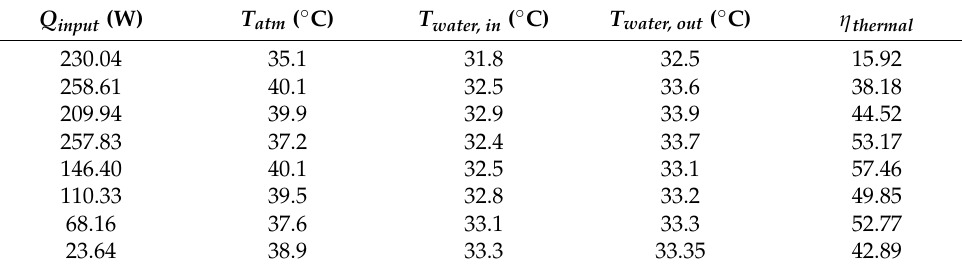
Table 1. Variation of thermal efficiency with heat